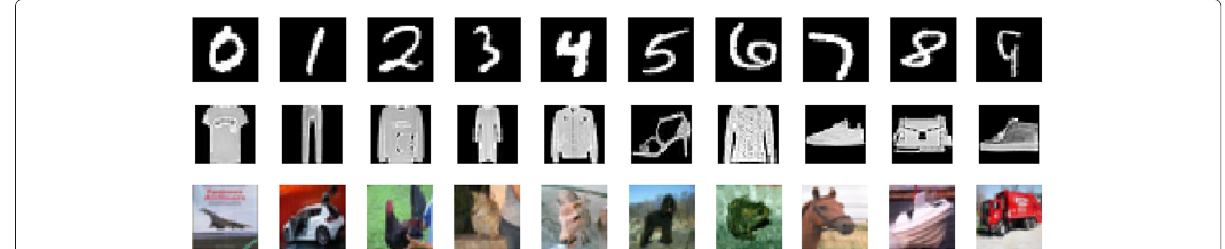
Fig. 10 Examples of original images from each class from MNIST (top line), Fashion-MNIST (middle line), and CIFAR-10 (bottom line) data sets